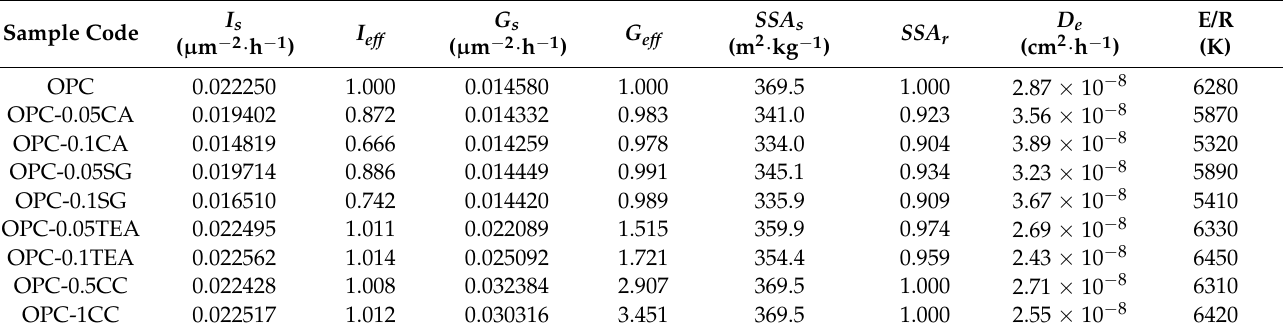
Figure 4. The results of fitting using Equation (28) to the calorimetric data of cement with different set-controlling admixtures. Table 4. Hydration kinetics parameters of cement with set-controlling admixture.